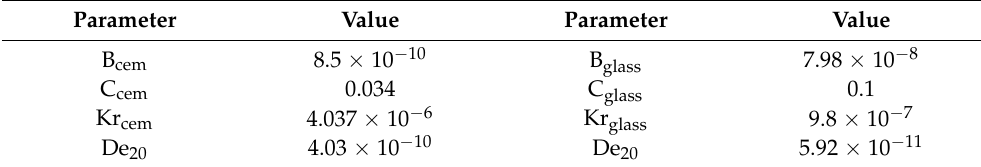
Table 3. Values of numerical simulation parameters.